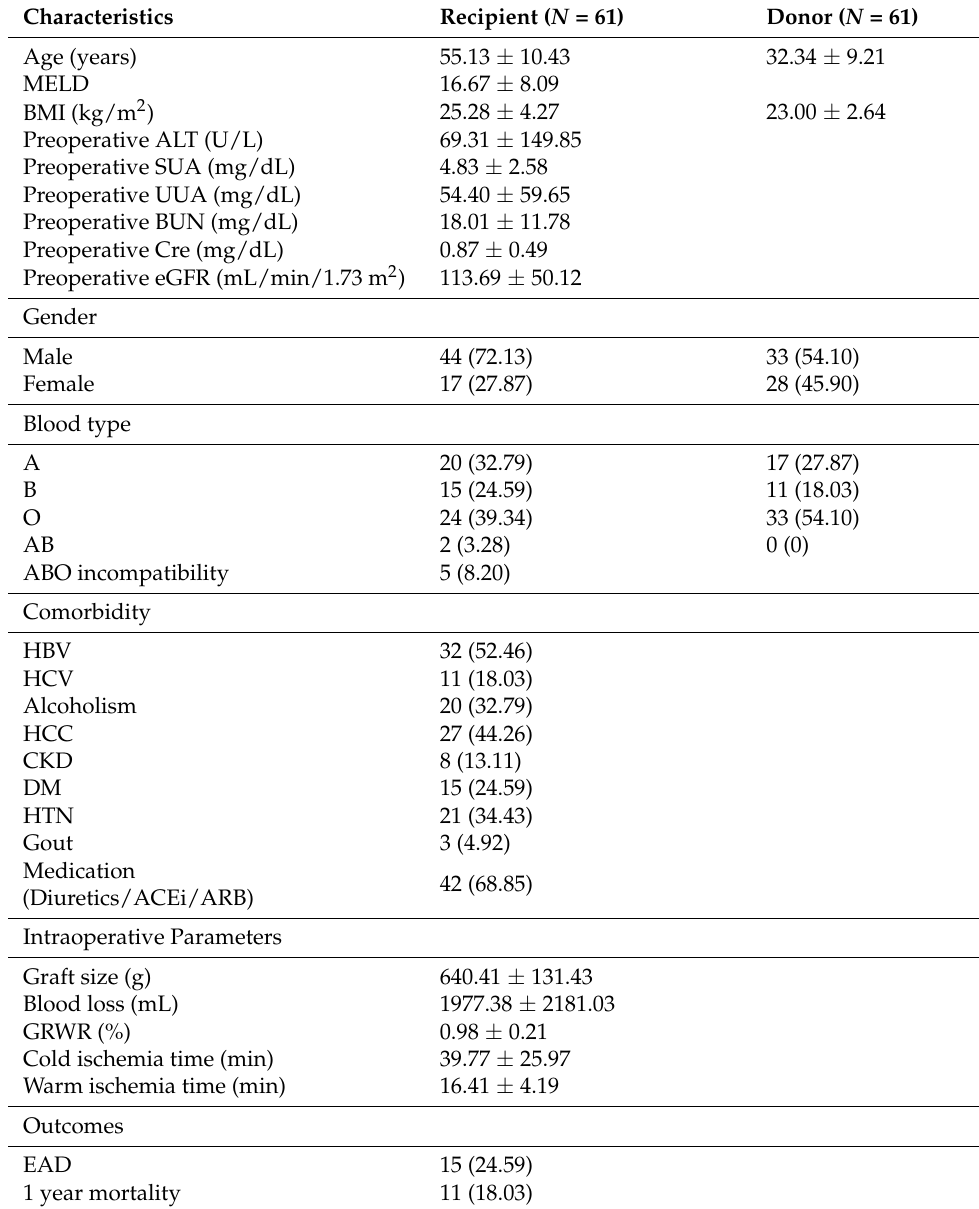
Table 1. Baseline characteristics of liver transplantation